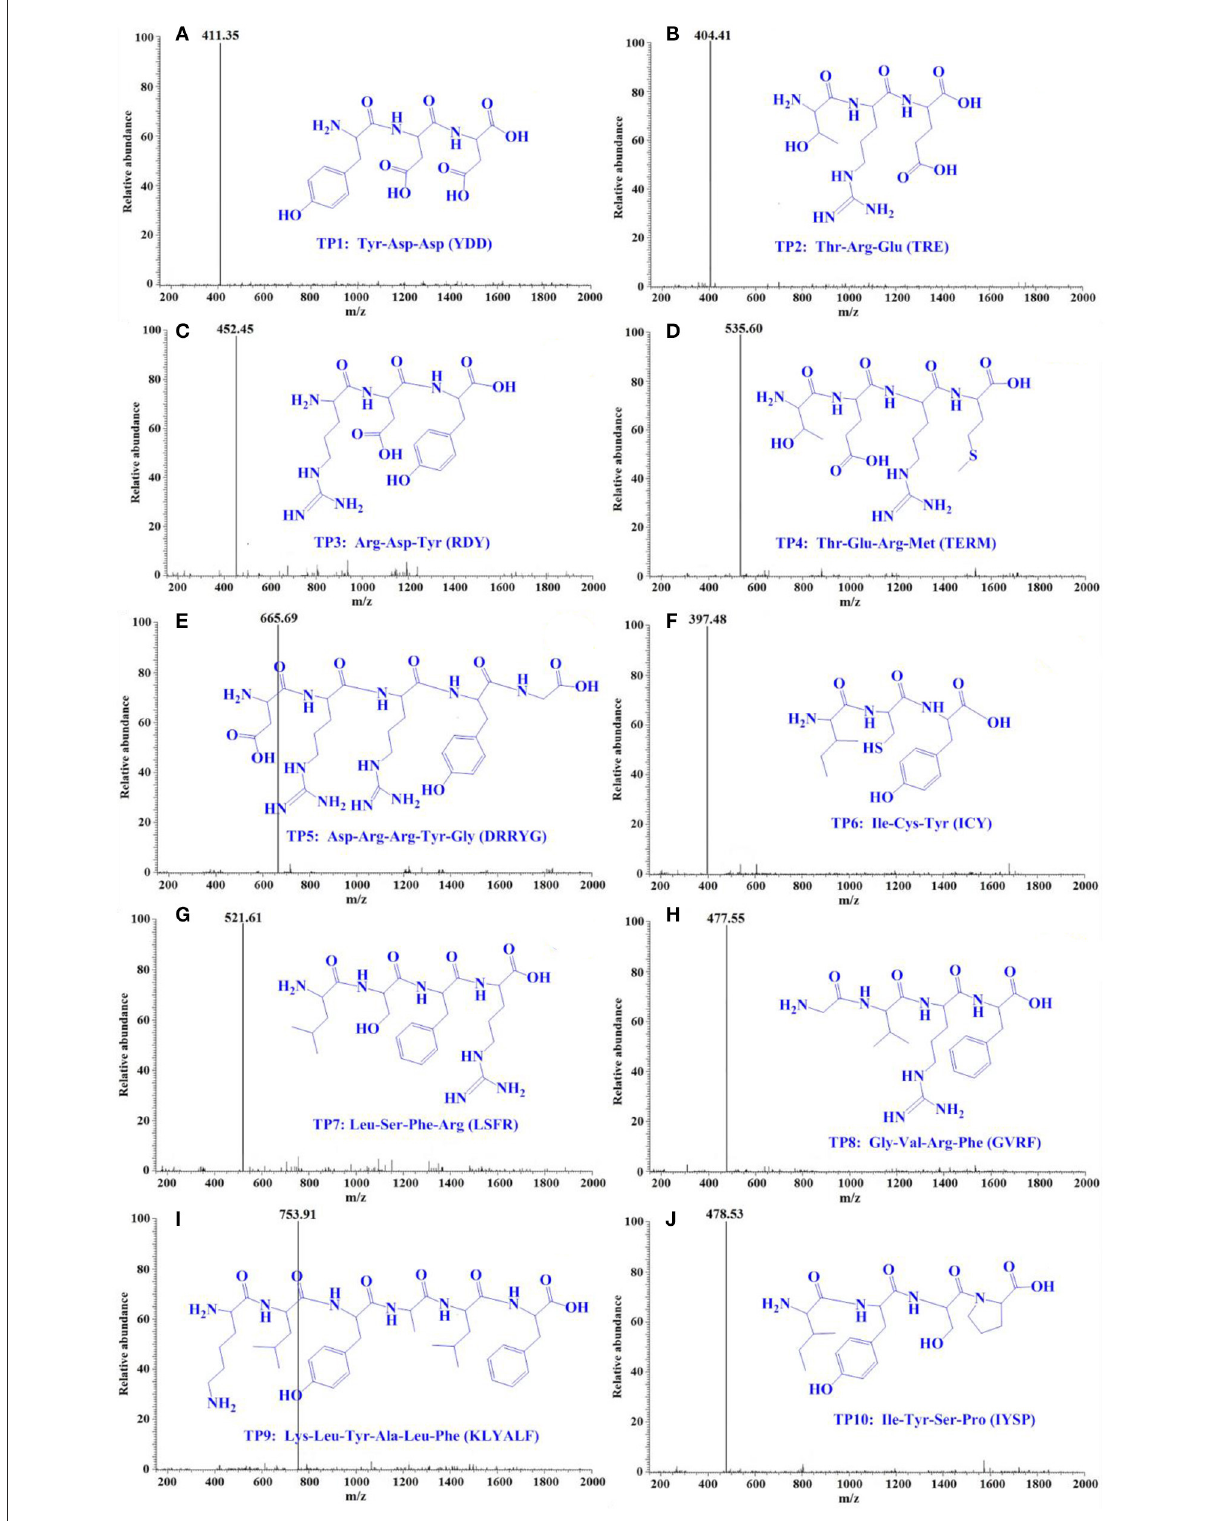
FIGURE5 Mass spectrogram of 10 ACEi peptides (TP1–TP10) from protein hydrolysate of skipjack tuna milts (TMH). (A) TP1, (B) TP2, (C) TP3, (D) TP4, (E) TP5, (F) TP6, (G) TP7, (H) TP8, (I) TP9, and (J)